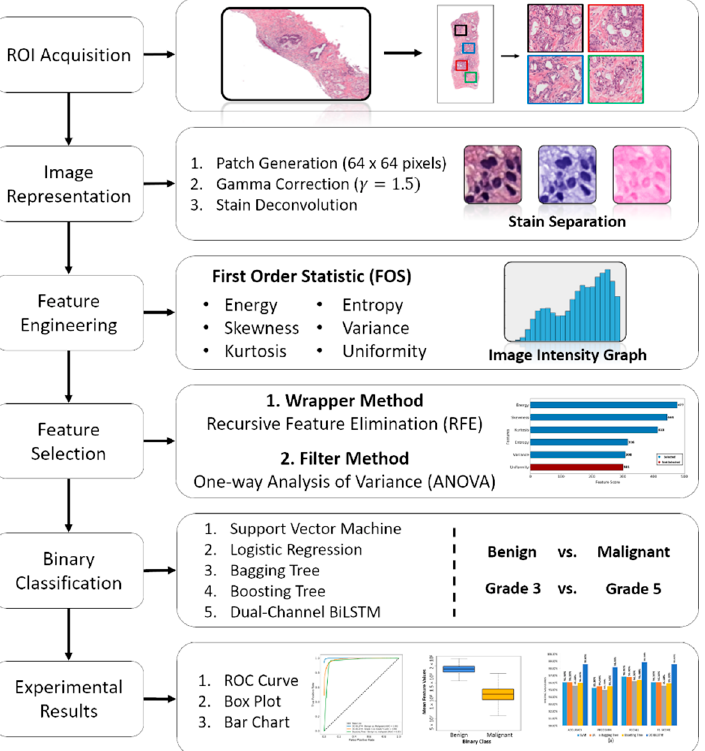
Figure 5. The proposed pipeline of the research work. Each step in the process flow diagram is carried out separately and independently.